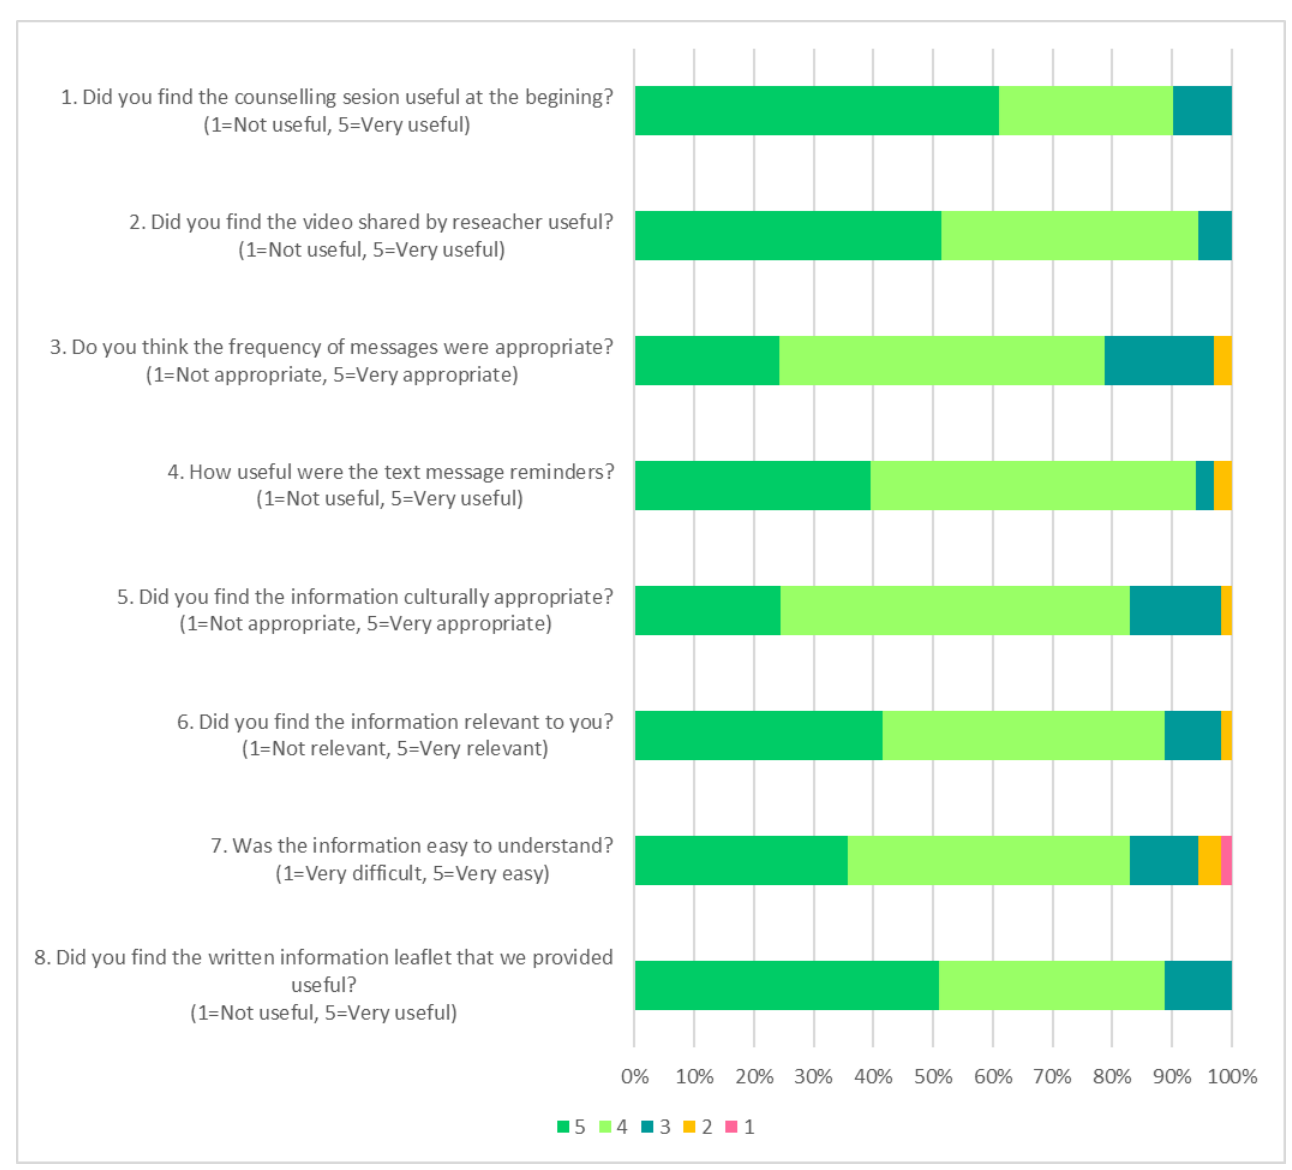
Figure 3. The acceptability and suitability of the intervention materials. The response rate for each question was: 1 ( n = 41/41); 2 (35/41); 3 (33/41); 4 (33/41); 5 to 8 (53/54). Question 1 to 4 was only applicable to the intervention groups ( n = 41) and responded to by those engaged with the intervention strategies.